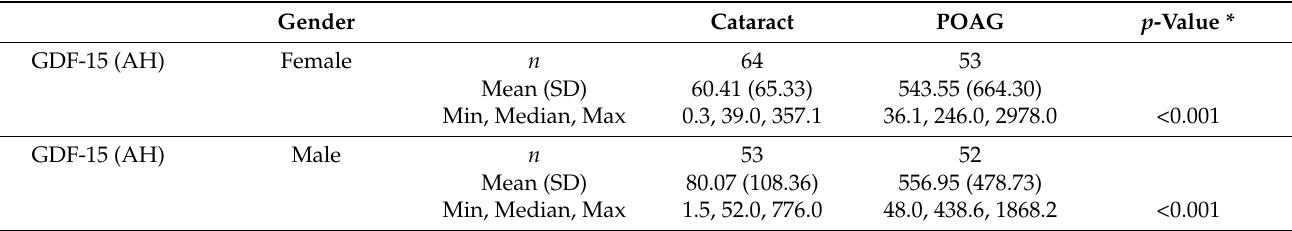
Figure 2. Elevated levels of GDF15 in aqueous humor samples from POAG patients. Aqueous humor samples derived from POAG patients ( n = 105) showed significantly increased levels of GDF15 (by 7.4-fold) compared to age- and gender-matched non-glaucoma cataract patient samples ( n = 117). The box and whisker plots represent median and the interquartile range in the distribution. p -values were based on Wilcoxon rank sum test of difference between medians. Abbreviations: GDF15, growth/differentiation factor-15; POAG, primary open-angle glaucoma. Table 1. GDF15 levels in the aqueous humor of male and female POAG and cataract